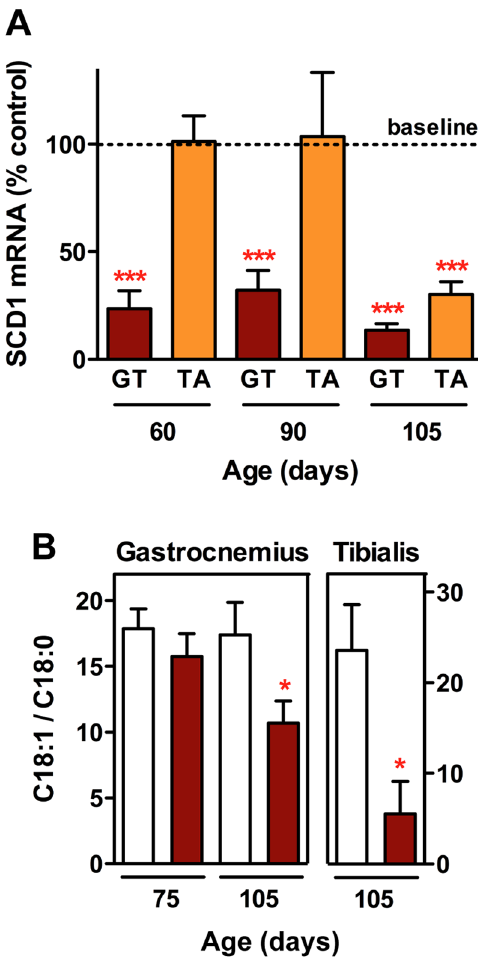
Figure 1. SCD1 expression and activity in ALS mouse muscle. (A) Time course of SCD1 expression in gastrocnemius (GT, brown columns) and tibialis anterior (TA, orange columns) from SOD1(G86R) mice at indicated ages. Wild-type expression is represented by 100% baseline. *** P , 0.001 (One sample t-test, n=5–11). (B) C18:1/C18:0 fatty acid ratio in gastrocnemius and tibialis anterior from SOD1(G86R) mice (brown columns) and wild-type littermates (white columns) at indicated ages. * P , 0.05 (1-way ANOVA followed by Bonferroni’s multiple comparison test for gastrocnemius, and unpaired t -test for tibialis anterior, n=3–10). the expression of stearoyl-CoA desaturase-1 (SCD1), an enzyme that introduces the first cis double bond in the delta-9 position of saturated fatty acyl-CoA substrates. The preferred substrates are palmitoyl-CoA (C16:0) and stearoyl-CoA (C18:0), which are converted to palmitoleoyl-CoA (C16:1) and oleoyl-CoA (C18:1),